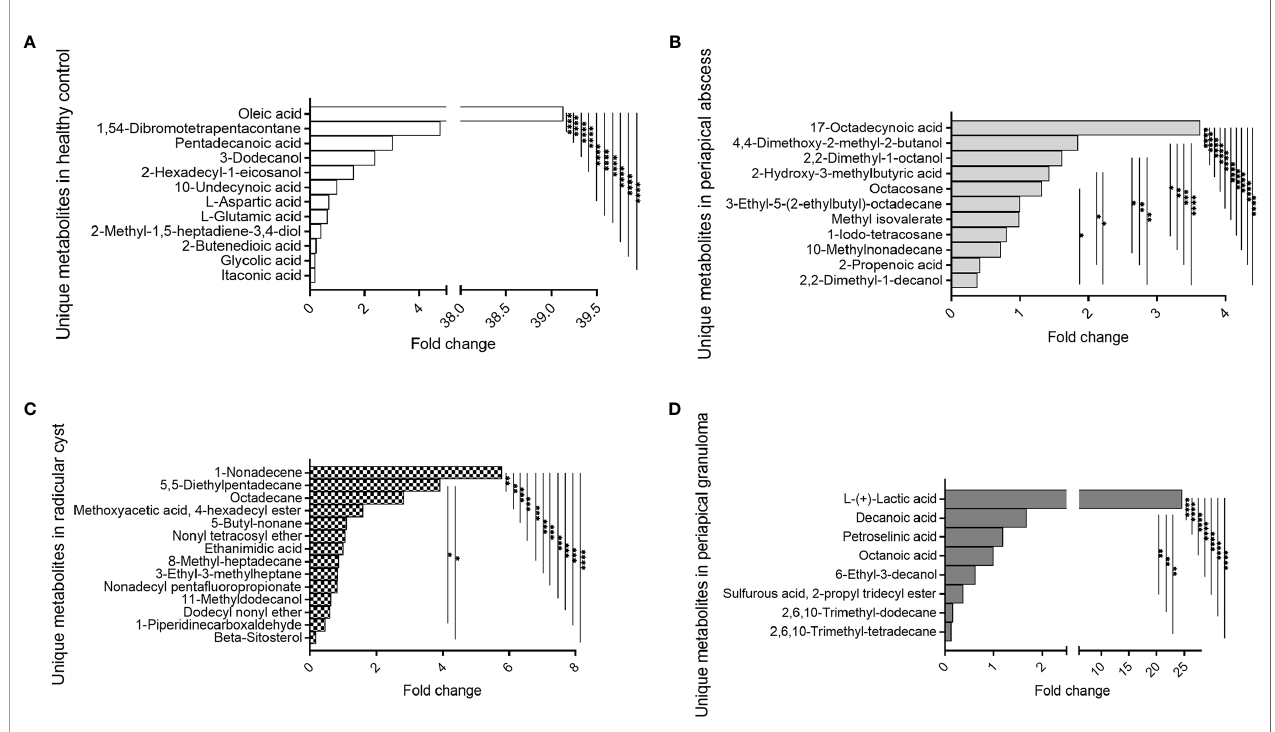
FIGURE 4 | Unique metabolites exclusively identi fi ed in speci fi c lesion type compared with healthy control. 10-Undecynoic acid value was regarded as one-fold change and employed for the measurement of other metabolites in healthy pulp control. 3-Ethyl-5-(2-ethylbutyl)-octadecane value was regarded as one-fold change and employed for the measurement of other metabolites in periapical abscess. Ethanimidic acid value was regarded as one-fold change and employed for the measurement of other metabolites in radicular cyst, and octanoic acid value was regarded as one-fold and employed as a reference for the measurement of fold change for the other metabolites in periapical granuloma. The data display the fold change of the area under the peak of unique metabolites in each group. The data were analyzed using one-way analysis of variance (ANOVA) using Tukey ’ s multiple comparisons test. P -value ≤ 0.05 was considered as signi fi cant. (A) Metabolites identi fi ed only in healthy control. (B) Metabolites identi fi ed only in periapical abscess. (C) Metabolites identi fi ed only in periapical cyst. (D) Metabolites identi fi ed only in periapical granuloma. * reveals that P -value < 0.05, ** reveals that P -value < 0.01, *** reveals that P -value < 0.001, **** reveals that P -value <